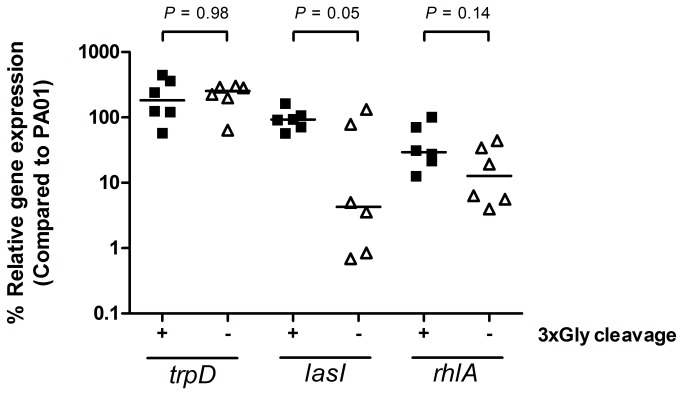
Link between 3xGly cleavage and expression of QS-genes.QS-gene expression was determined in a subset P. aeruginosa strains as described in material and methods. Normalized expression of the QS-circuit gene lasI, QS-target gene rhlA and the QS-independent gene trpD measured in mid-log phase grown bacteria is shown as relative values (%) compared to the P. aeruginosa PAO1 control strain. A horizontal line indicates the median expression levels. P-values were calculated using unpaired, two-tailed students t-tests.